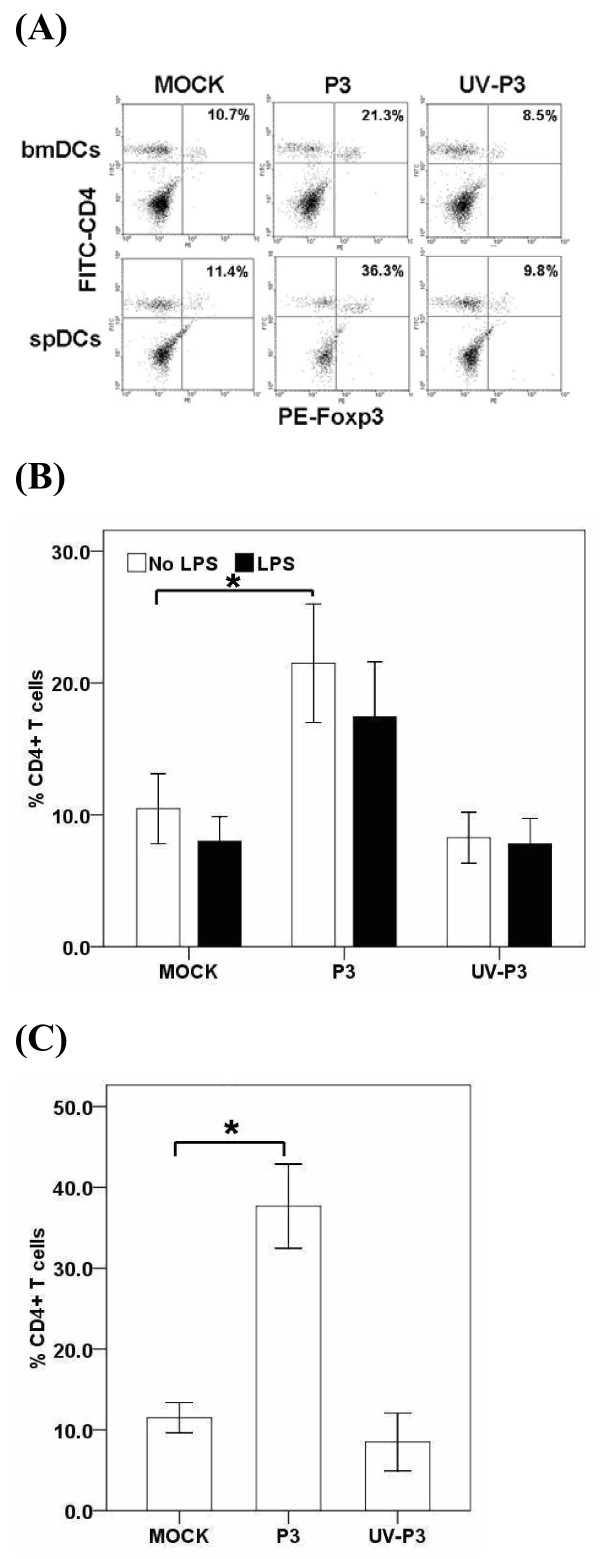
Effects of P3 infection on DCs-induced differentiation of regulatory T cells. 1 × 105 mock-, P3-, UV-P3- or LPS-treated bmDCs were incubated with 1 × 106 allogeneic naïve T cells for 5 days. T cells were purified and doubly labeled for CD4 and Foxp3, and assessed by FACS. The in vivo Treg in splenocytes were purified and examined by FACS from mice inoculated with 1 × 105 PFU P3 or identical UV-P3 i.p. for 5 days. Representative result was shown from three independent experiments (A). The percentage represented the ratio of CD4+ Foxp3+ cells in CD4+ T cells. P3-infected bmDCs elicited the Treg differentiation in vitro (B). After P3 infection or UV-P3 stimulation of mice i.p., Treg differentiation in vivo was analyzed immediately (C). Results were expressed as the means ± SD of triplicates. *, P < 0.05.